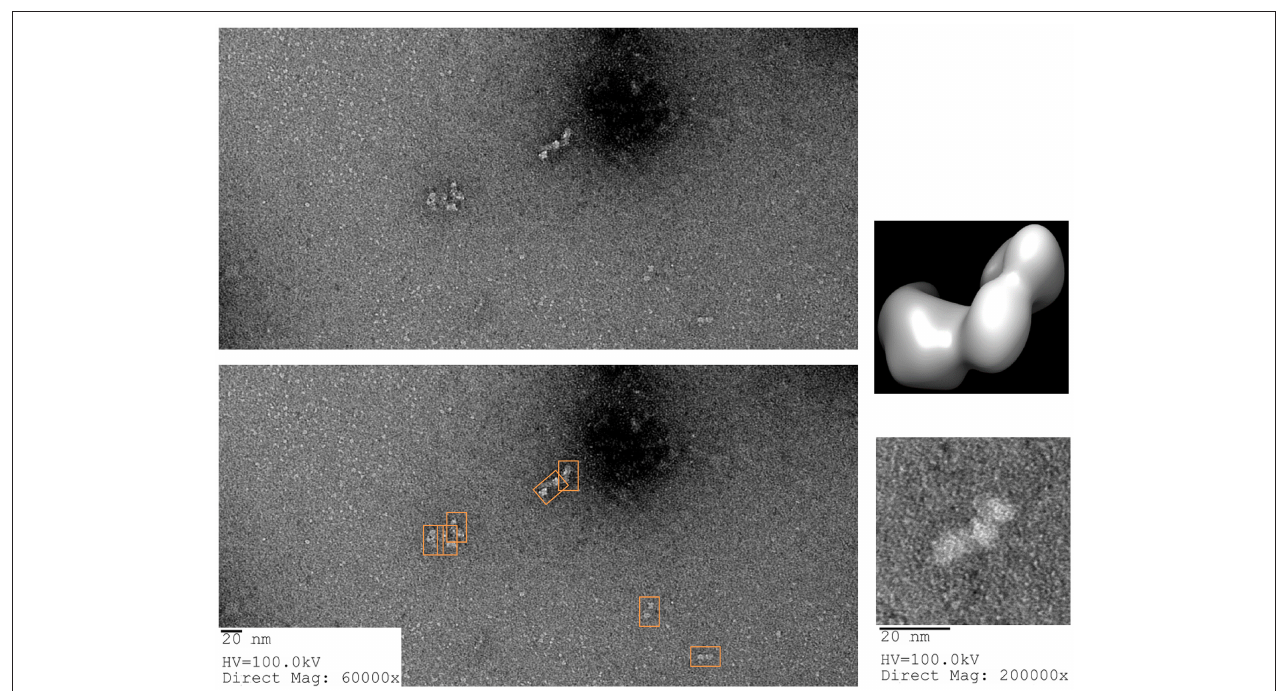
FIGURE 11 | ATP Release of Tetanus Neurotoxin from GroEL Biosensor. (Left) Representative field of gridded and stained TeNT after release from GroEL biosensor using ATP. Multiple copies of the protein can be seen as white on dark background (orange boxes on the duplicate image below). (Right) Higher magnification of isolated TeNT molecules. In the magnified field, the three domains of tetanus can be observed. For comparison, the envelope and ribbon structure from Figure 7 have been oriented in the same view as the particle and recolored to match the white on black of the EM image. Images obtained at